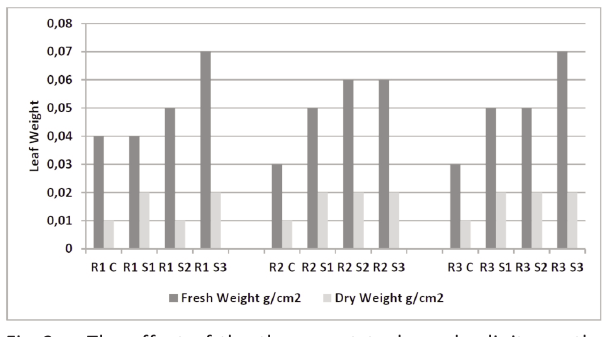
Fig. 2 - The effect of the three rootstocks and salinity on the ratio of ‘Superior’ leaf fresh and dry weights (g) to leaf area (cm 2 ).